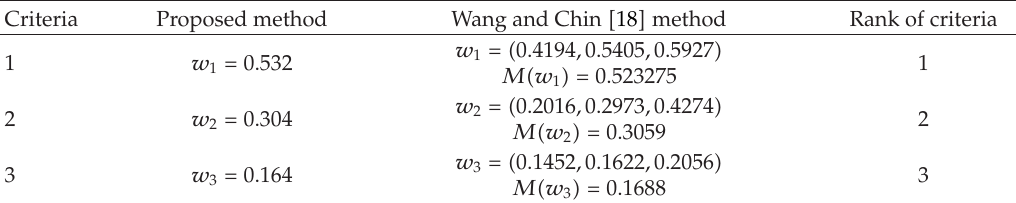
Table 6: The obtained weights of proposed method and Wang and Chin (cid:4) 18 (cid:5) method for